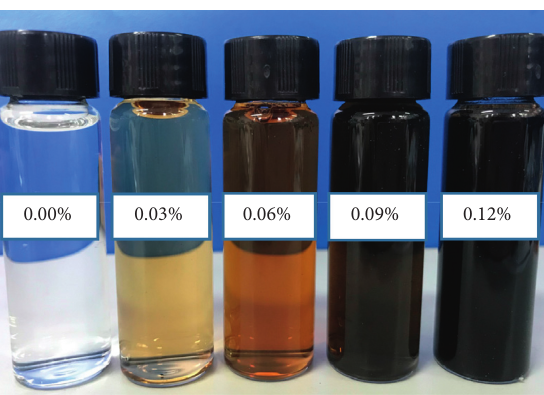
Figure 2: GO solution with different concentrations.